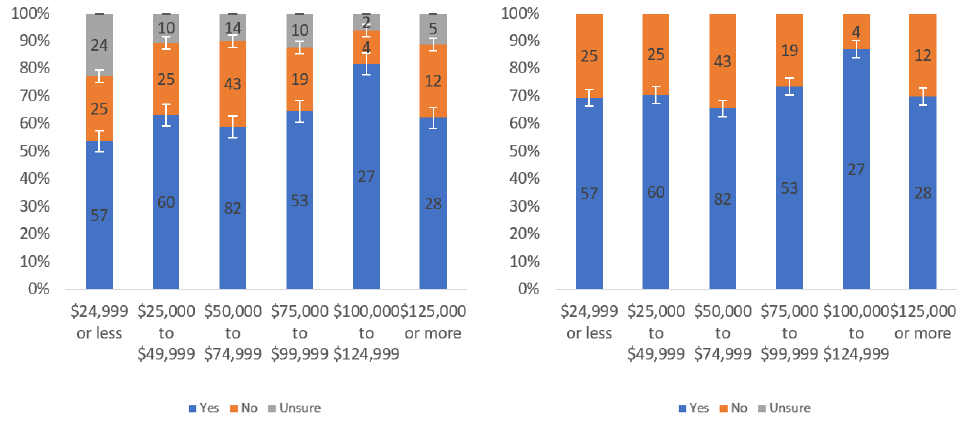
Figure 29. Responses regarding respondents’ willingness to review by income level including ( left ) and excluding ( right ) unsure responses.